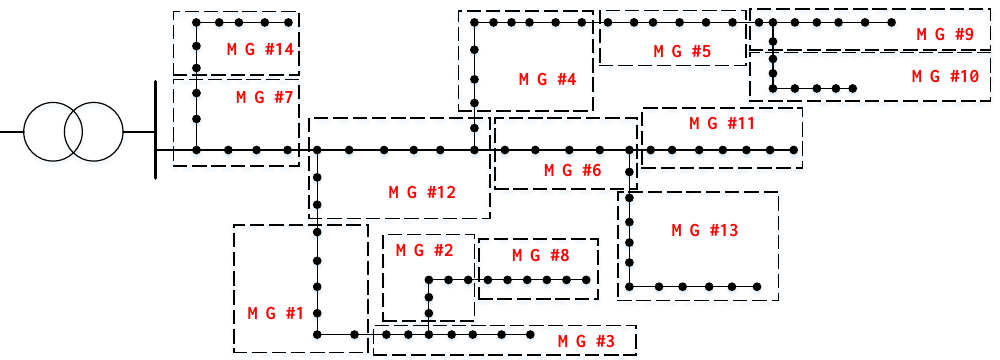
Figure 5. A realistic distribution network topology in Guizhou